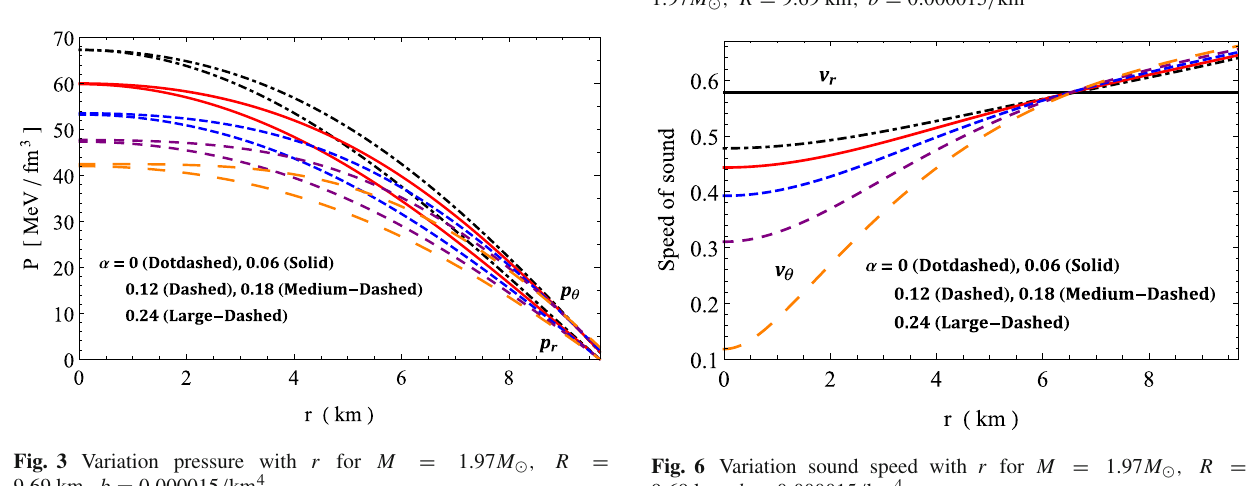
Fig. 2 Variation energy density with r for M = 1 . 97 M (cid:3) , R = 9 . 69 km , b = 0 . 000015 / km 4